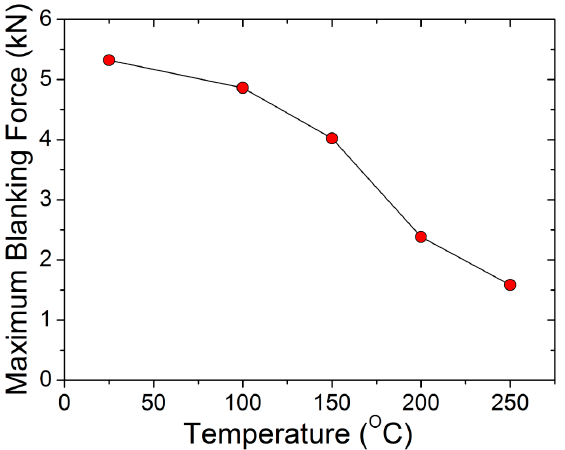
Figure 22. Relationship between maximum blanking force (as kN) and heating temperature for the punch–die clearance of